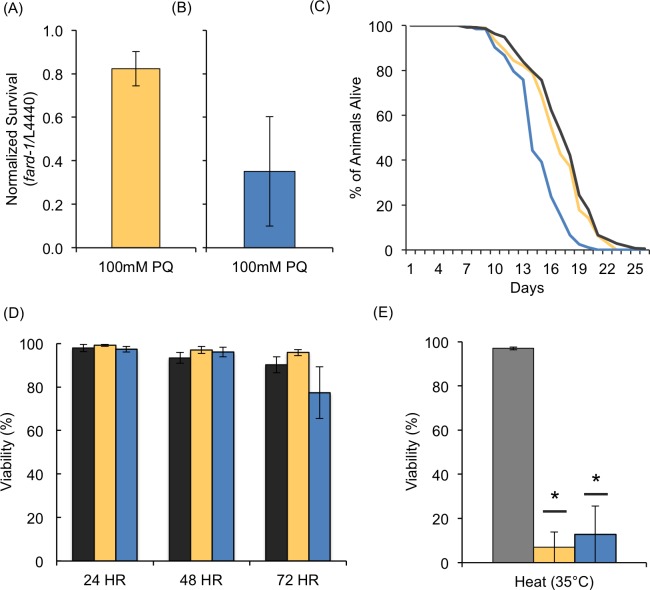
fard-1 is Required for Thermotolerance but not Osmotic Stress in Adult Animals.(A) A sample of a large population of adult-only fard-1 RNAi-treated animals was assessed for viability after 48 hours of 100mM PQ treatment in each population prepared for biochemical analysis. (B) Developmental fard-1 RNAi-treated populations were assayed in 100mM PQ as well; however, fewer animals were needed as no HPLC-MS/MS was carried out on those animals. The data presented is normalized to the L4440 controls to account for the differences in culture size. Individual comparisons can be found as S5 Fig. (C) Lifespan analysis was completed for developmental fard-1 (blue) and adult-only fard-1 RNAi treatment (yellow). There was a significant reduction (p<0.001) in the average lifespan with developmental RNAi (13.4 ± 0.8 days) versus control (18.0 ±0.5 days). (D) Viability was assessed for the same fard-1 treatments following exposure to 500mM NaCl and (E) after 24 hours of heat stress at 35°C. Data presented here is a result of at least 4 biological replicates containing a minimum of 40 animals per condition in each replicate. SEM is presented, and *p<0.05 was determined by unpaired t-tests using Holm-Sidak corrections for multiple comparisons where applicable.